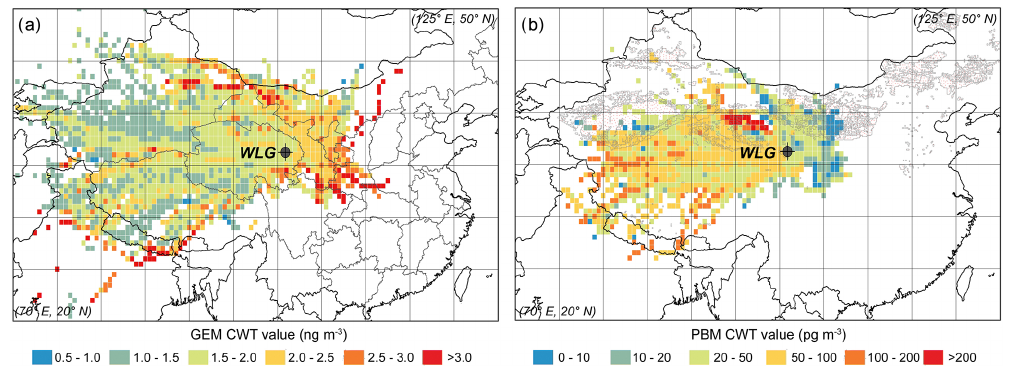
Figure 5. Identified source regions of atmospheric GEM and PBM at WLG during the study period. (a) Gridded (0.5 ◦ × 0.5 ◦ ) values for GEM, and (b) gridded (0.5 ◦ × 0.5 ◦ ) values for PBM. Gray-line-enclosed regions indicate desert locations in China.